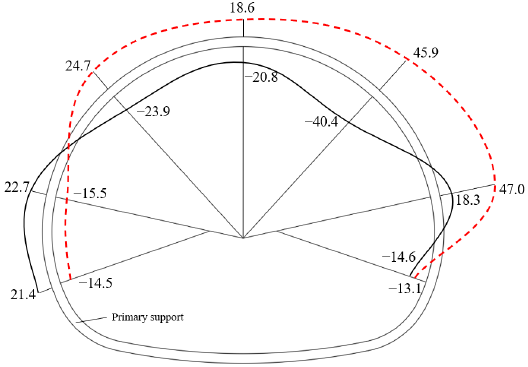
Figure 27. Stress distribution diagram of the main limb steel tubes of the arch (Unit: MPa).